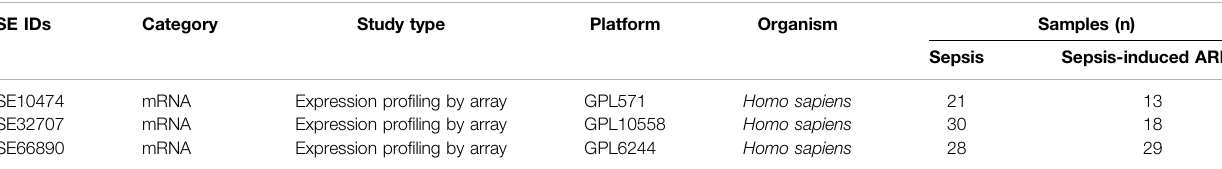
TABLE 1 | Details of the microarray datasets used in the